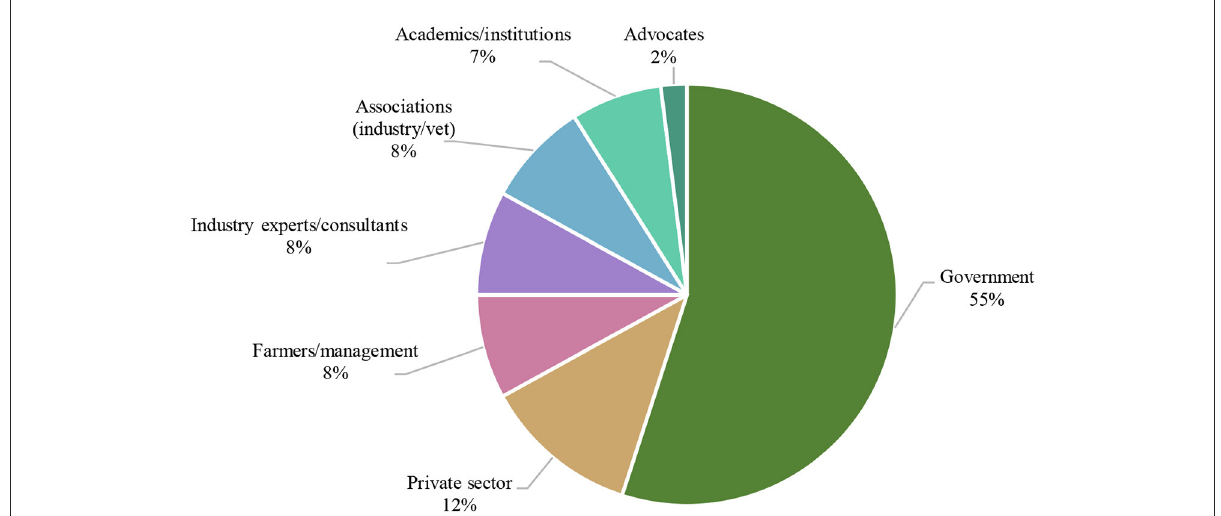
FIGURE7 Egg producers’ perception of the stakeholders that are most frequently deemed as required to provide support for transitioning to cage-free systems by